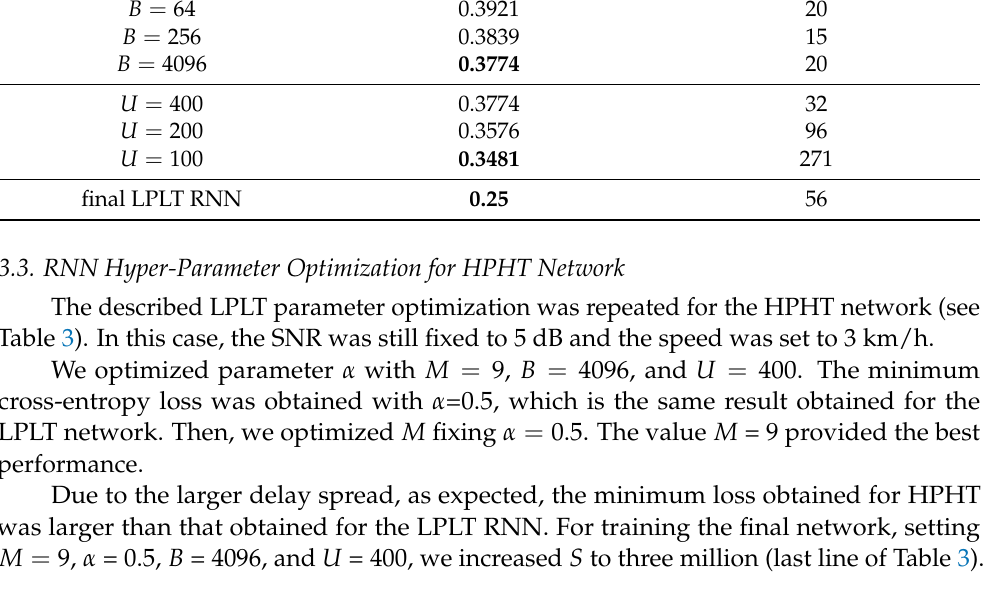
Table 3. RNN parameter optimization. Minimum binary cross-entropy loss of the validation data set for the HPHT